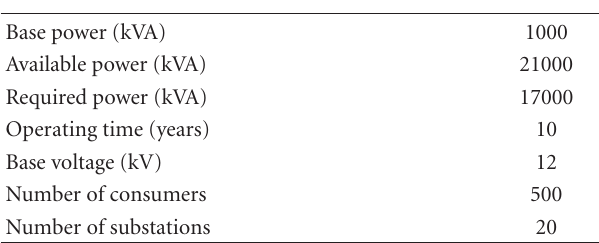
Table 2: Network